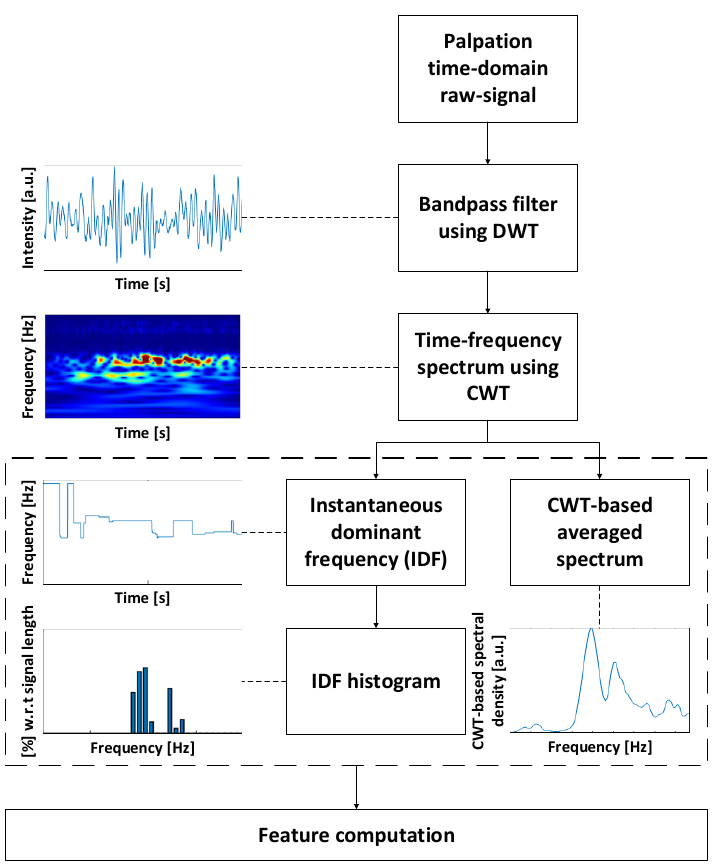
Figure 3. Block diagram of the signal analysis methodology including a bandpass filter with passband f p ≈ 5–7000 Hz. The indicators IDF, IDF’s histogram, and averaged spectrum, as well as the CWT spectrum from which they are derived form the basis for the subsequent feature